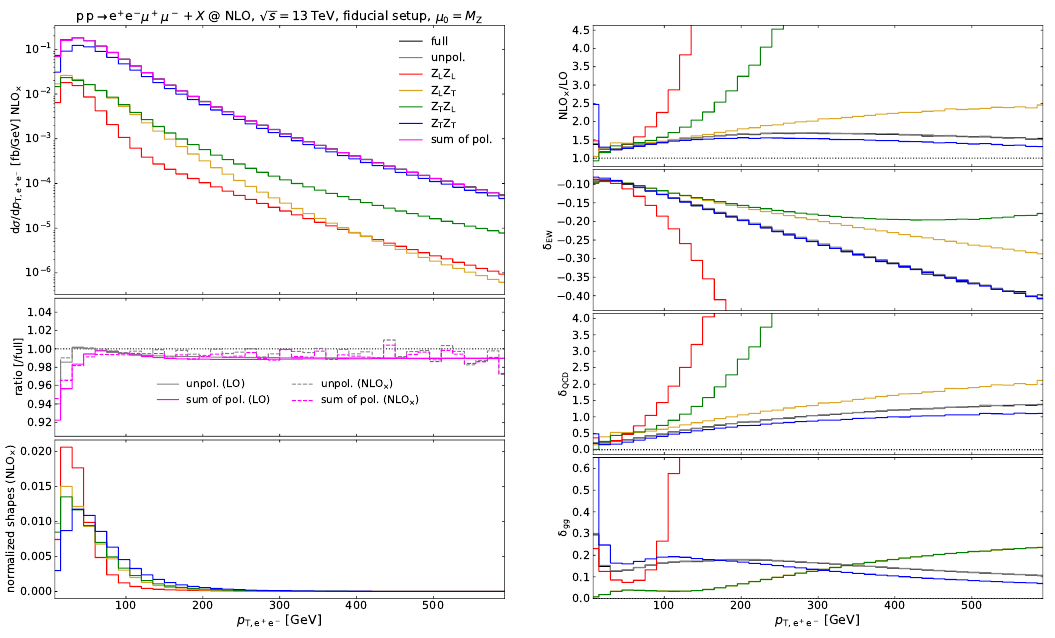
Figure 9 . Distributions in the transverse momentum of the e + e − system. Unpolarized and doubly- polarized results are shown for ZZ production at the LHC in the fiducial setup described in sec- tion 2.5 with polarizations defined the CM frame. Left panel from top down: NLO differential × cross-sections, ratios of DPA over the full result, normalized NLO shapes (unit integral). Right × panel from top down: NLO -factor, NLO EW corrections δ , NLO QCD correction δ , gg × K EW QCD contribution δ . All curves in the right panel are relative to the LO gg